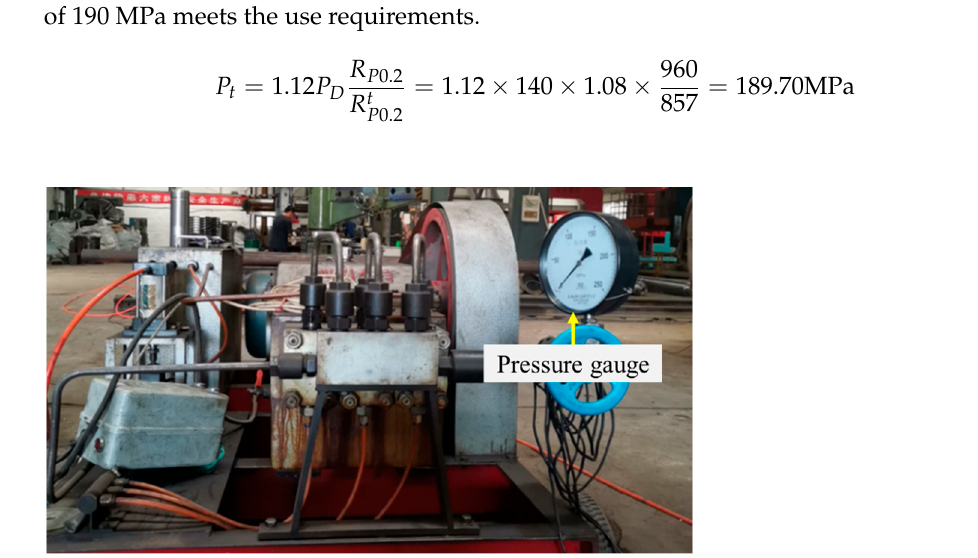
Figure 9. Pressure pump produced for a Sichuan jet.